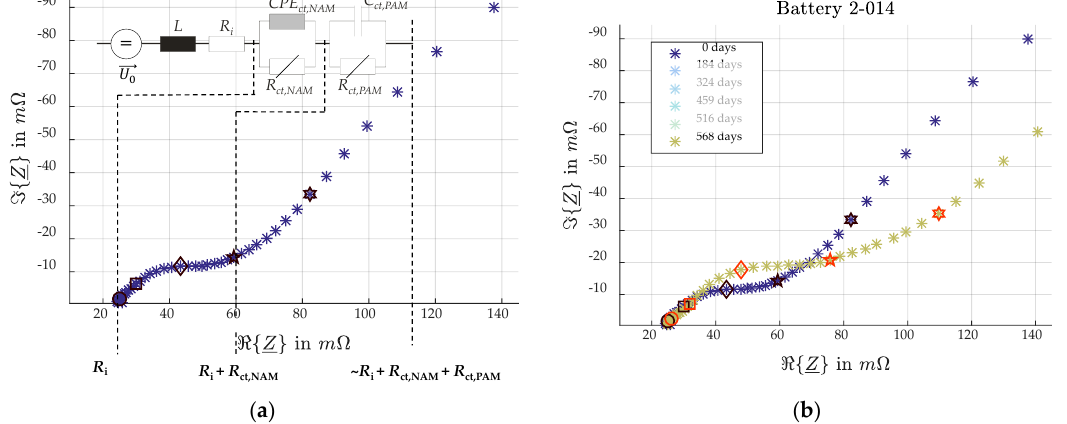
Figure 2. ( a ) Initially measured impedance spectrum of battery 2-014. The utilized equivalent electrical circuit (EEC) model for the fitting of the spectrum for a full 12 V AGM battery is depicted and the corresponding areas of the spectrum are marked. ( b ) Development of the measurable EIS spectrum from the initial measurement to the check-up after 568 days for battery 2-014. The following frequencies are marked: 1 kHz (